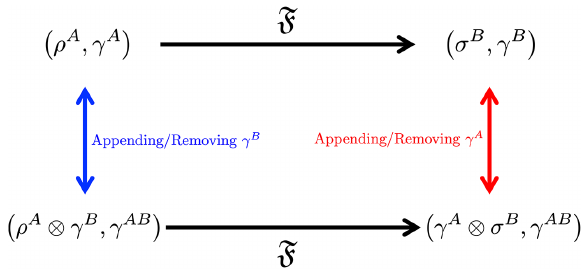
FIG. 1. Equivalence of conversions. The top conversion with two different Gibbs states γ A and γ B is equivalent to the bottom conversion with the same Gibbs state γ AB